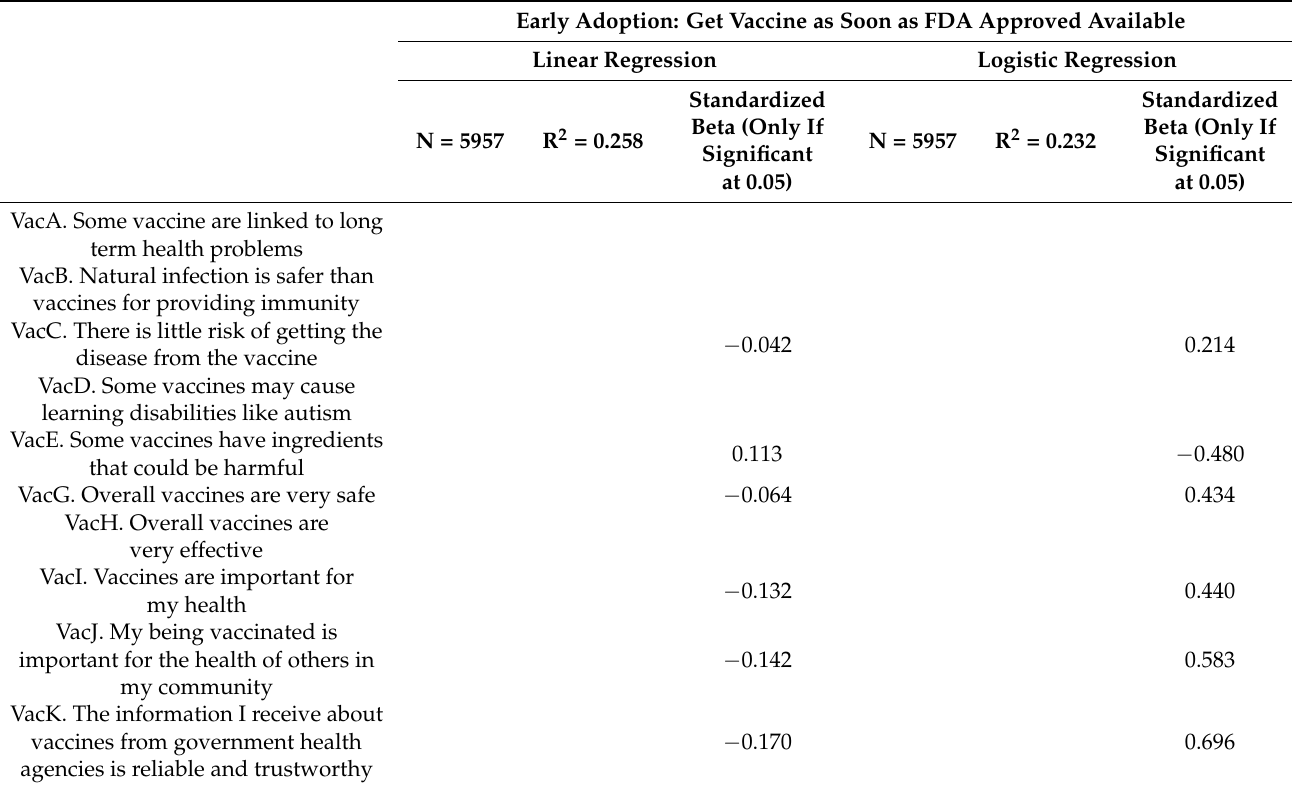
Table A4. Linear and Logistic Regression of Likelihood of Vaccine Adoption (Very, Somewhat, Not Too, Not at All) by General Beliefs toward vaccines.